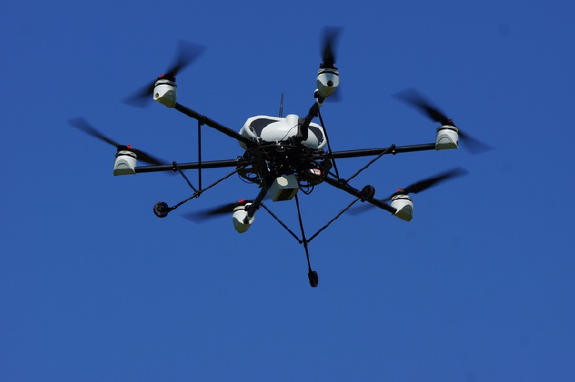
Figure 7. The airborne LiDAR system.